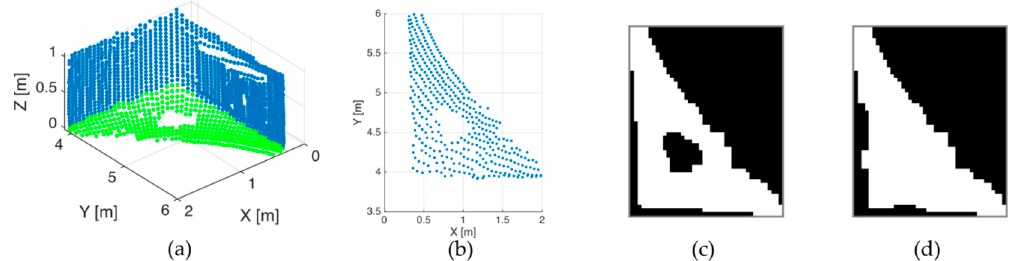
Figure 13. Input point cloud and its level images: ( a ) Point cloud of the 1st level in the Z-axis; ( b ) Segmented point cloud from ( a ); ( c ) Level image after the application of morphological operations; ( d ) Filled level image.